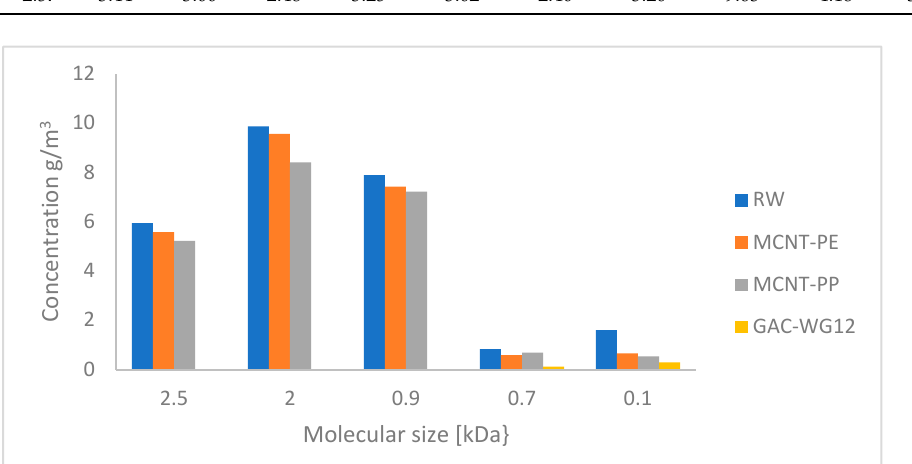
Figure 4. Distribution of molecular weight in raw water and filtrates.